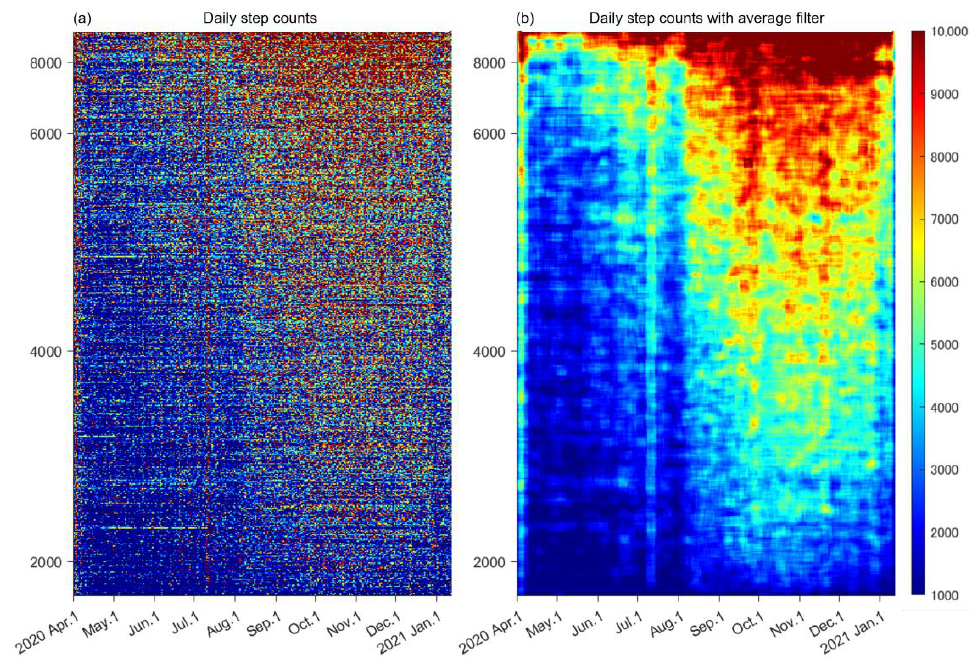
Figure 3. Daily step counts of 603 participants with moving averages. ( a ) Daily step counts repre- sented as colormaps in descending order of median daily step counts from top to bottom. ( b ) Daily step counts after applying average filters with 10 participants × 7 days matrix.